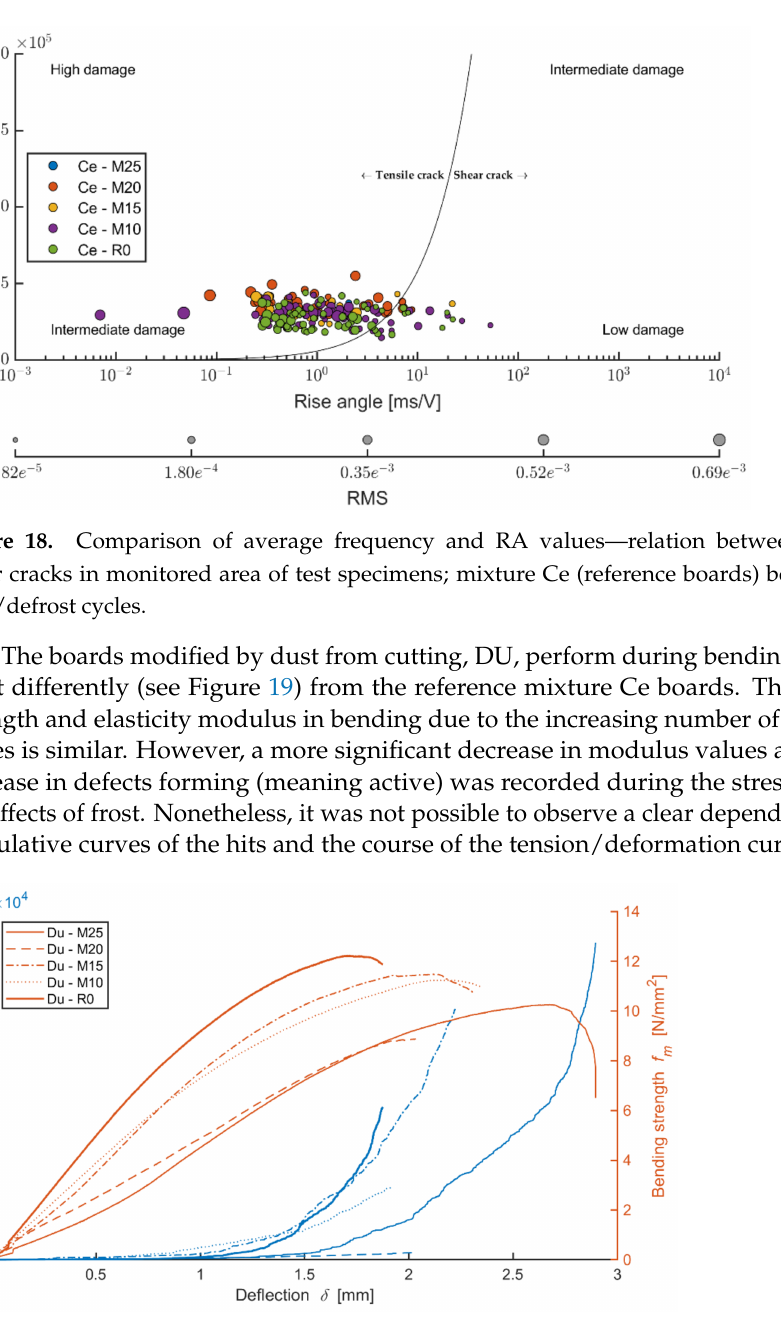
Figure 19. Comparison of bending strength, deflection and cumulative hits of representative test specimens (during mechanical load) of mixture DU (boards modified by dust DU) before and after frost/defrost